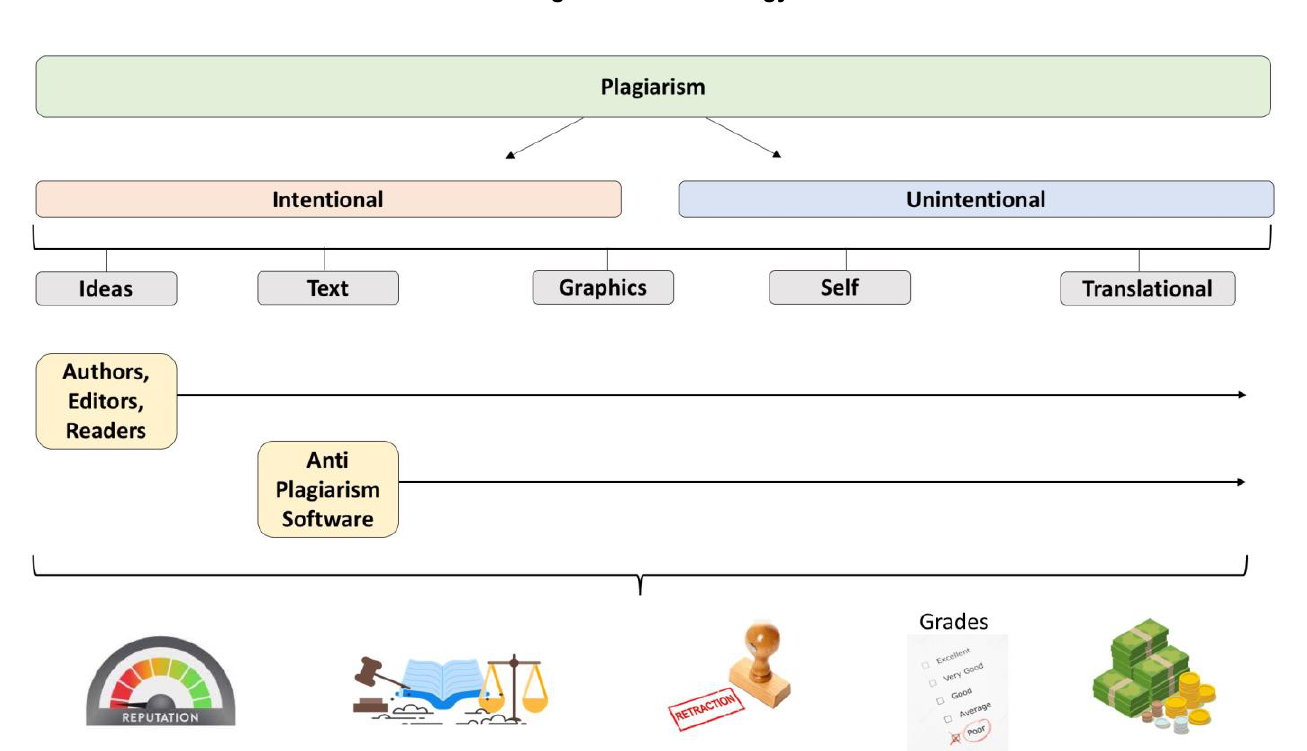
Figure 1. Methodology